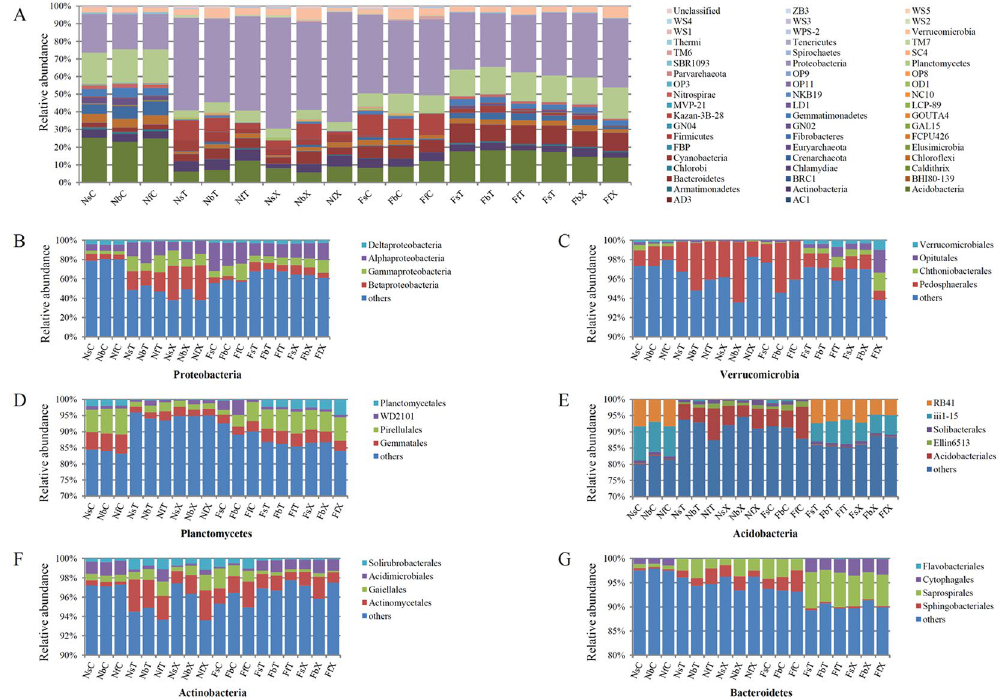
Figure 1. Bacterial community composition in samples of 18 different treatments. Two types of soils were used: nutrient-rich soil (N) and continuous cropping field soil ( F ). Three developmental stages: seedling (s), budding ( B ), and flowering ( F ). Two cultivars: upland cotton (T) and sea island cotton (X), without cotton control ( C ). Each samples was labelled by a three-letter code, such as NsT indicates that seedling of sea island cotton grown in nutrient-rich soil. ( A ) Bacterial community composition by different treatments; ( B ) Proteobacteria, ( C ) Verrucomicrobia, ( D ) Planctomycetes, ( E) Acidobacteria, ( F ) Actinobacteria, and ( G ) Bacteroidetes community composition in each sample. X-axis shown relative abundance, y-axis are different